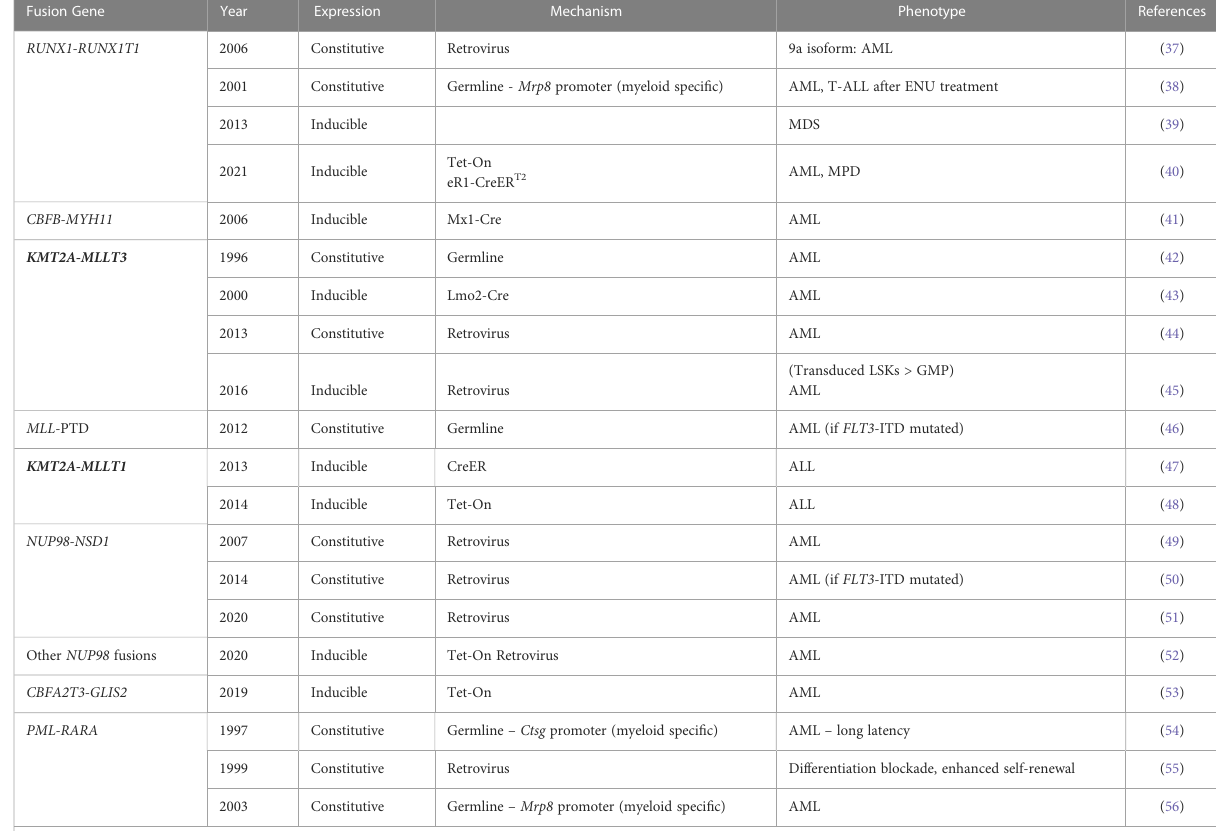
TABLE 1 Mouse models of fusion genes. Fusion